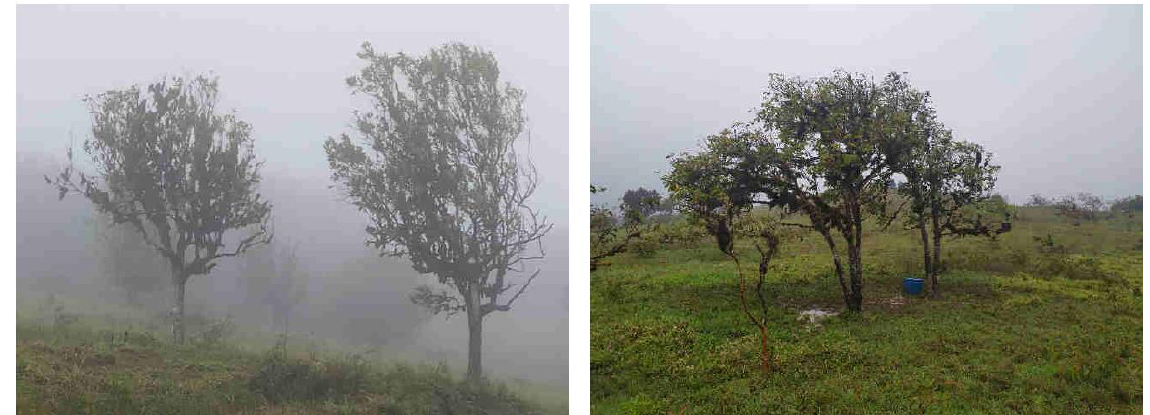
Figure A1. Endemic vegetation on San Cristobal polygons.